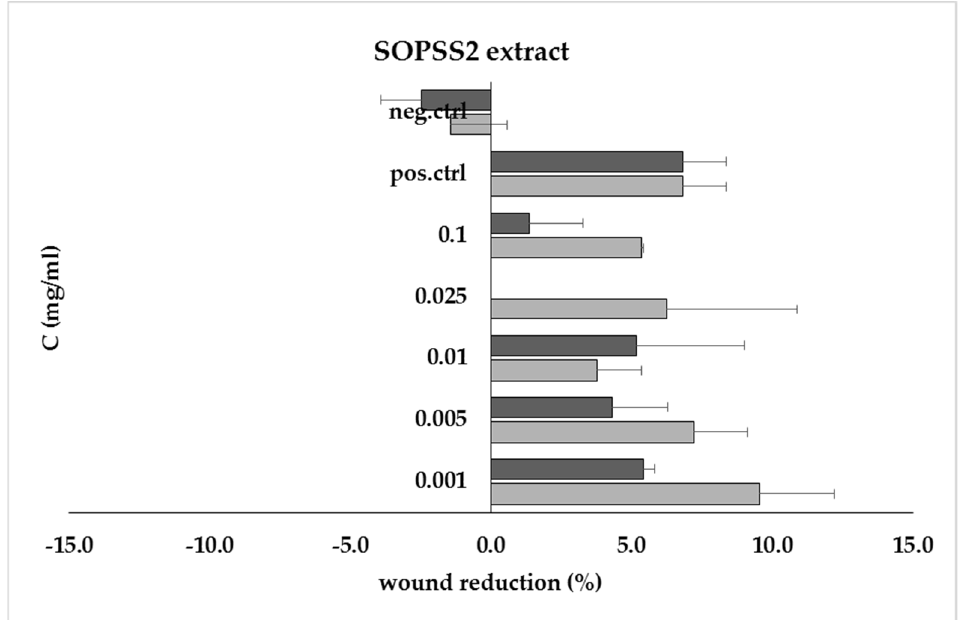
Figure 6. Wound recovery (% scratch reduction) at 24h ( ■ ) and 48h ( ■ ) for SOPSS2 root extract at concentrations ranging from 0.001mg/mL to 0.1mg/mL, compared to positive (pos.ctrl) and negative (neg.ctrl) controls.